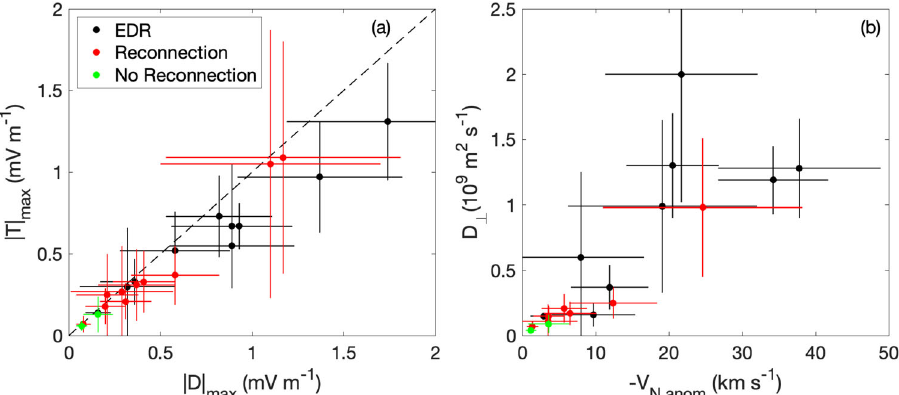
Fig. 5 Statistics of anomalous terms. Anomalous terms are calculated from 22 magnetopause current sheets with lower hybrid waves. The black points indicate EDR crossings, red points indicate reconnection crossings outside the EDR, and green points indicate boundary crossings without clear evidence of reconnection. The maximum values of the anomalous viscosity and anomalous drag for each event, ( j T j max and j D j max ), are comparable. The diffusion coef fi cient D ⊥ tends to increase with the negative of the anomalous fl ow V N,anom up to tens of km s − 1 , indicating signi fi cant fl ow from high to low density in the direction normal for large D ⊥ . a j T j versus j D j , b D ⊥ versus − V N,anom . The dashed line in panel ( a ) indicates j D j max max vertical lines indicate the uncertainties of j D j max and j T j max in ( a ) and V N,anom and D ⊥ in ( b ). See Methods, subsection Estimating the anomalous terms for details on the calculation of the